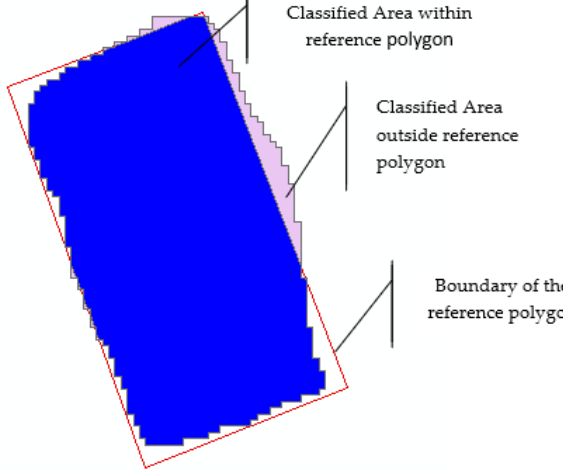
Figure 4. Figure illustrating computation of the overlap areas between classified pixels and the reference polygon. Only the building class is evaluated using this metric.